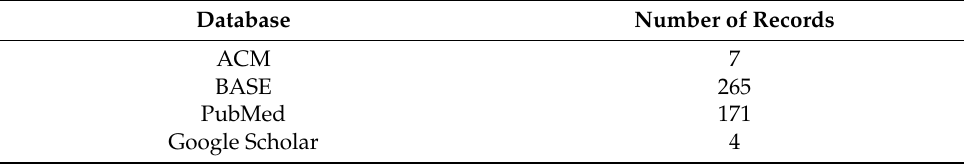
Table A2. Number of search results.